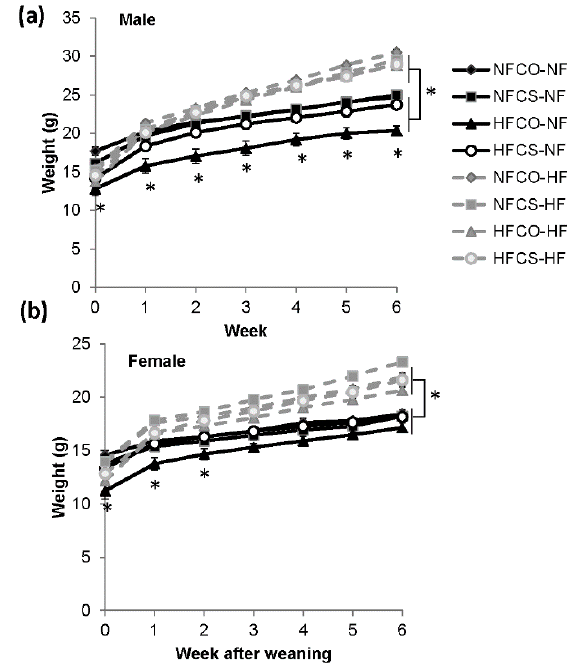
Figure 3. Mouse offspring weight during the 6-week post-weaning feeding. ( a ) Represents males and ( b ) represents females. Grey and dashed lines: post-weaning NF feeding groups, black and solid lines: post-weaning HF feeding groups. n = 12 for the postnatal NF groups and n = 16–20 for the postnatal HF groups for each sex. Data were analyzed using the general linear model. Values represent means ± SEM. *, p < 0.05; NF: normal fat; HF: high fat; CO: untreated control without choline; CS: choline supplemented.